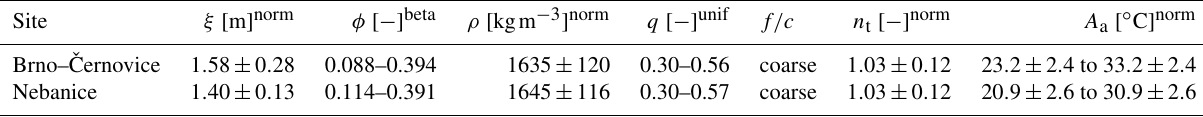
Table 2. Variables used to model palaeo-air temperature characteristics related to the cryoturbations at the Brno–ˇCernovice and Nebanice sites. Note that the superscripts norm, beta, and unif indicate normal, beta, and uniform distributions describing the respective variables.